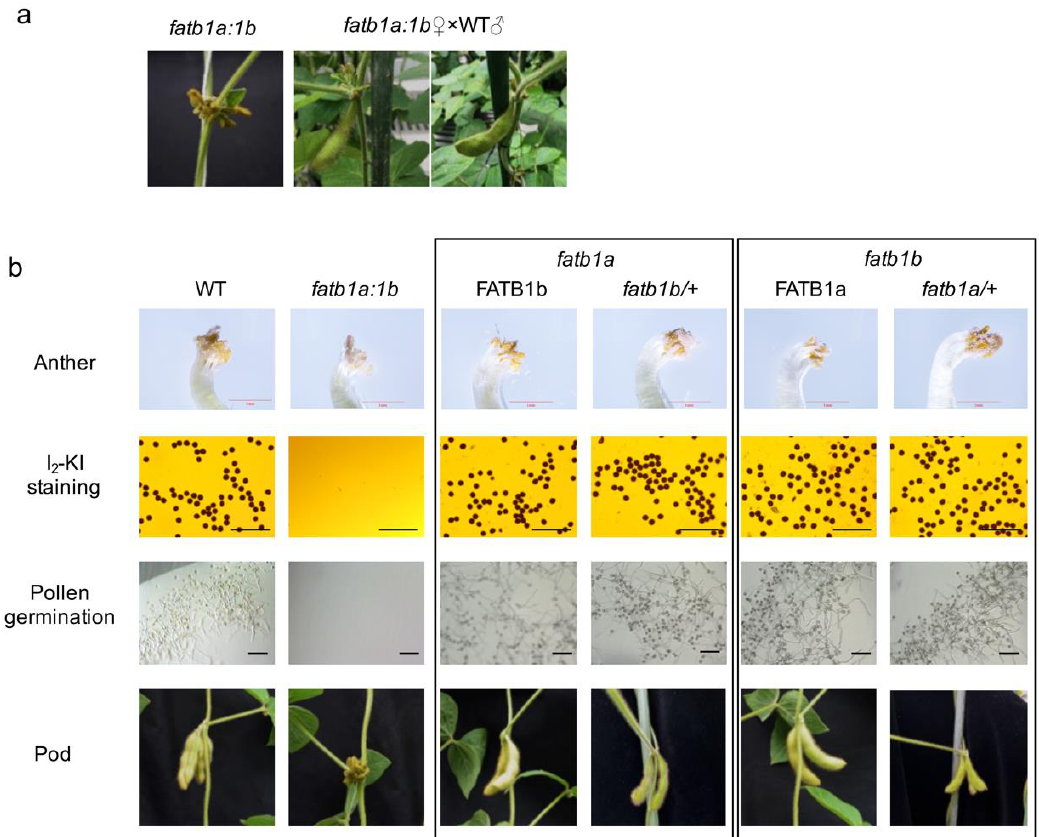
Figure 3. Double mutation of GmFATB1 leads to male sterility. ( a ) Successful seed sets (right two images) of fatb1a:1b after pollination with the WT pollens compared with the unfertilized fatb1a:1b pods (left image). ( b ) Processes of pollen and seed development. Anther, scale bar = 1 mm. I 2 -KI staining, scale bar = 200 µ m. Pollen germination, scale bar = 200 µ m. WT, wild type.